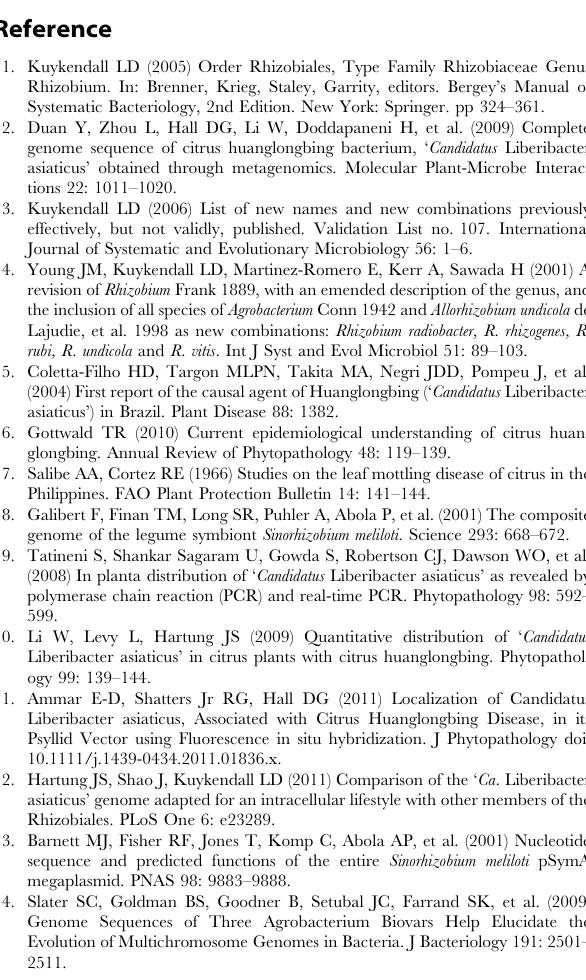
Table S1 Proteins shared between the Sinorhizobium meliloti plasmid pSymA, and the ‘Ca. Liberibacter asiaticus’ and Sinorhizobium meliloti chromosomes. The protein IDs and annotations used by NCBI and the